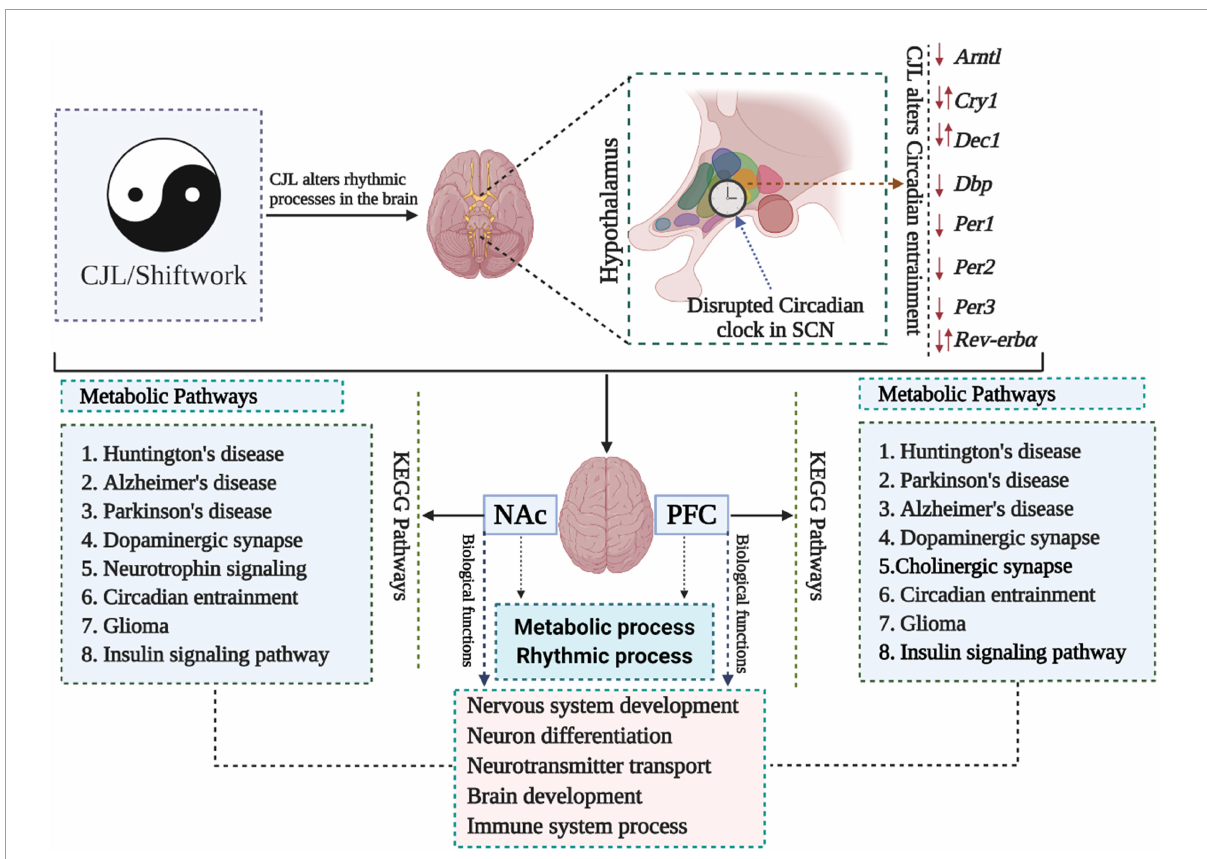
FIGURE1 Chronic jetlag (CJL) mediated molecular alterations in the brain. Expression levels of a number of circadian clock-related genes were altered in mice exposed to CJL, indicating that the circadian clock was disrupted. In addition, metabolic pathways were also found altered in response to CJL. Moreover, pathways associated with important neurological diseases and biological functions were found affected by CJL.